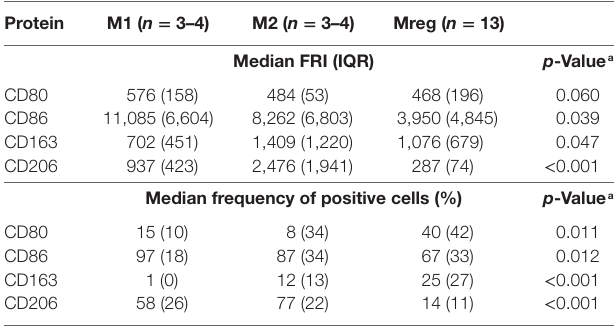
Table 1 | Characteristics of Mregs and other macrophage